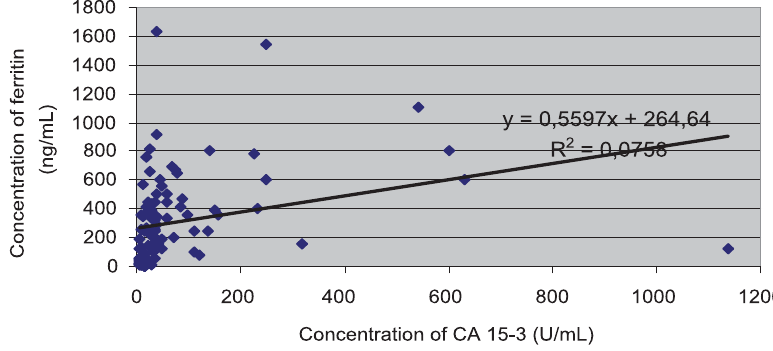
FIGURE 3. Comparison of CA 15-3 and ferritin in serum measured by Architect CMIA. The correlation coef fi cient r = 0.274.